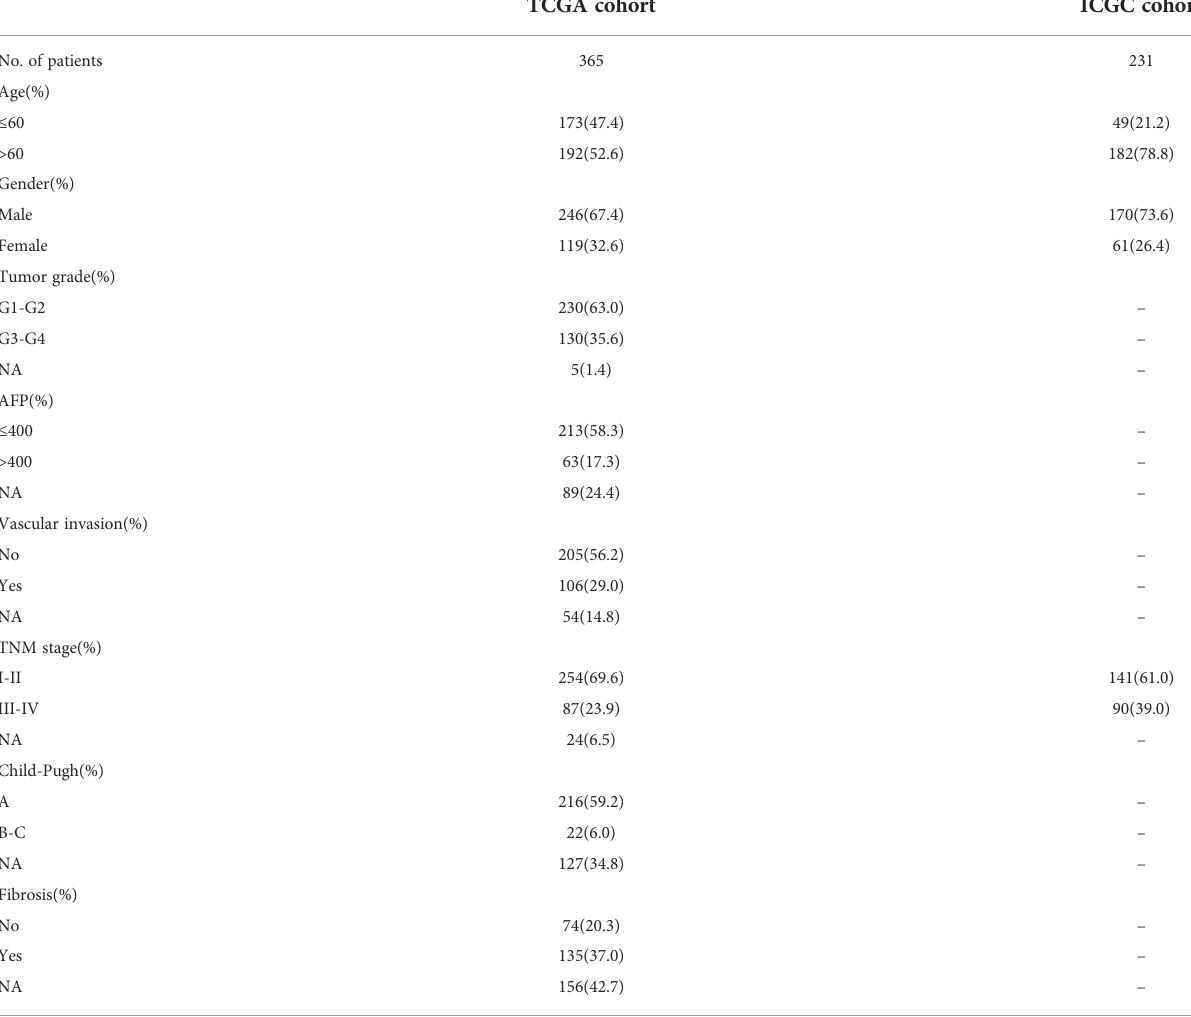
TABLE 1 Baseline characteristics of HCC patients in the TCGA and ICGC